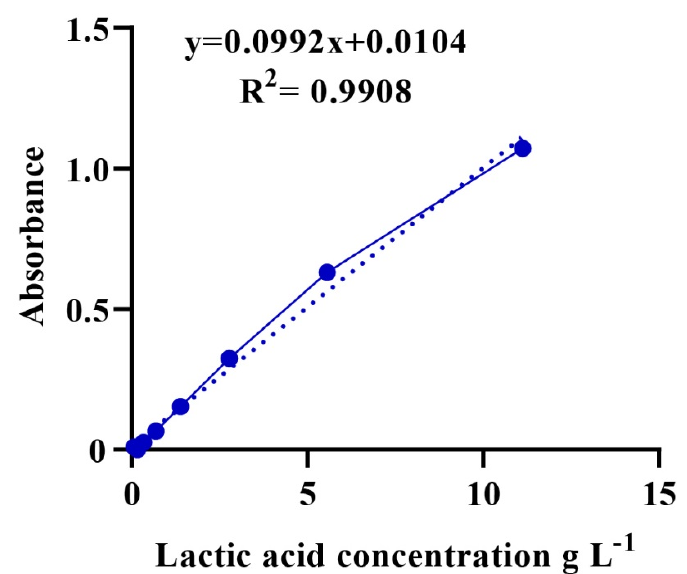
Figure A1. Calibration curve showing the absorbance and its corresponding concentration.